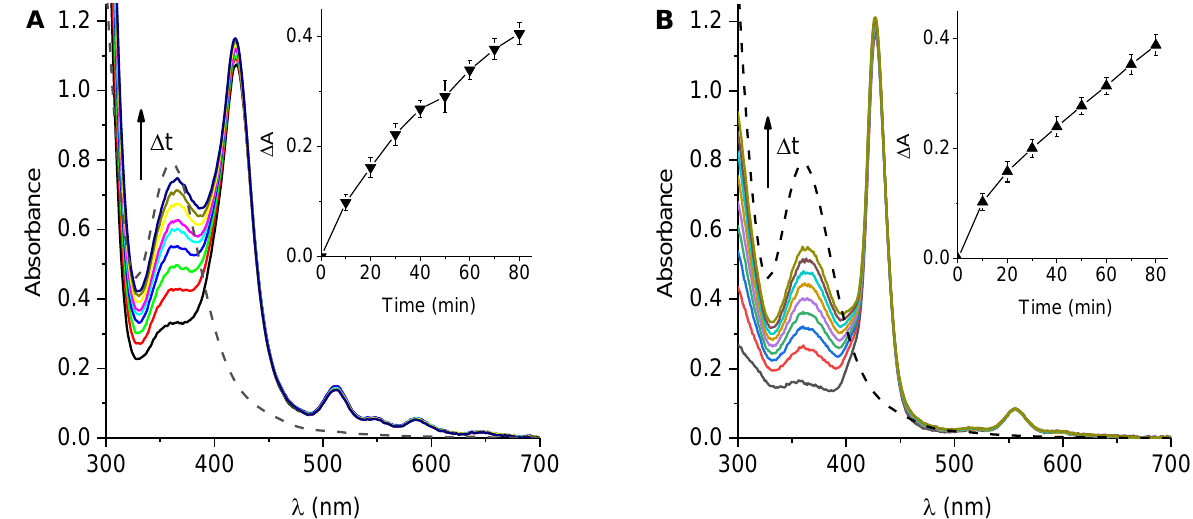
Figure 8. Absorption spectra of ( A ) PTPPF 16 -EDA and ( B ) PZnTPPF 16 -EDA containing 100 mM KI in DMF/10% after different irradiation times ( ∆ t = 10 min, solid lines) with white light (44 mW/cm 2 ) and Lugol’s solution (dashed line). Inset: changes in absorbance at 360 nm after different irradiation times.